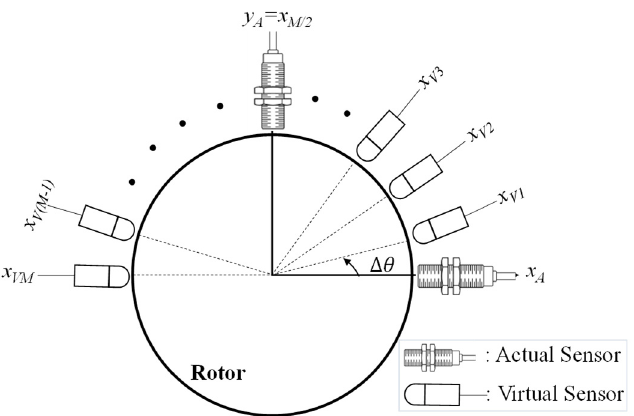
Figure 4. The idea of virtual vibration signals from the actual vibration signals through coordinate transformation.